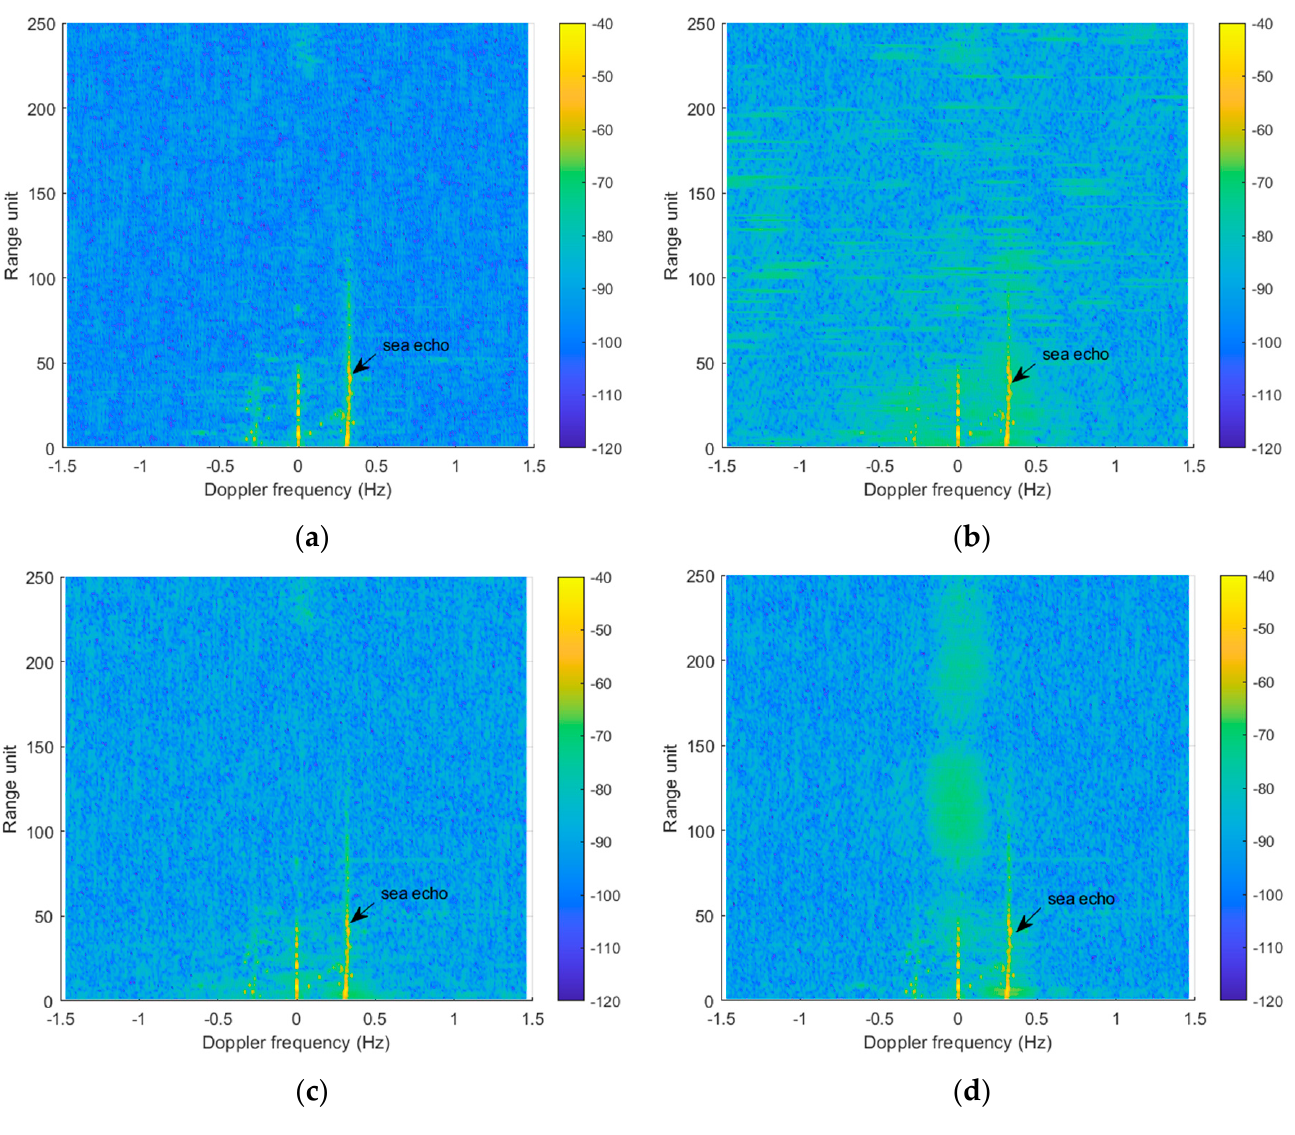
Figure 8. The range − Doppler maps of the STI − removed results: ( a ) The RPCA method; ( b ) The BOS method; ( c ) The proposed method; ( d ) The CEMD method.